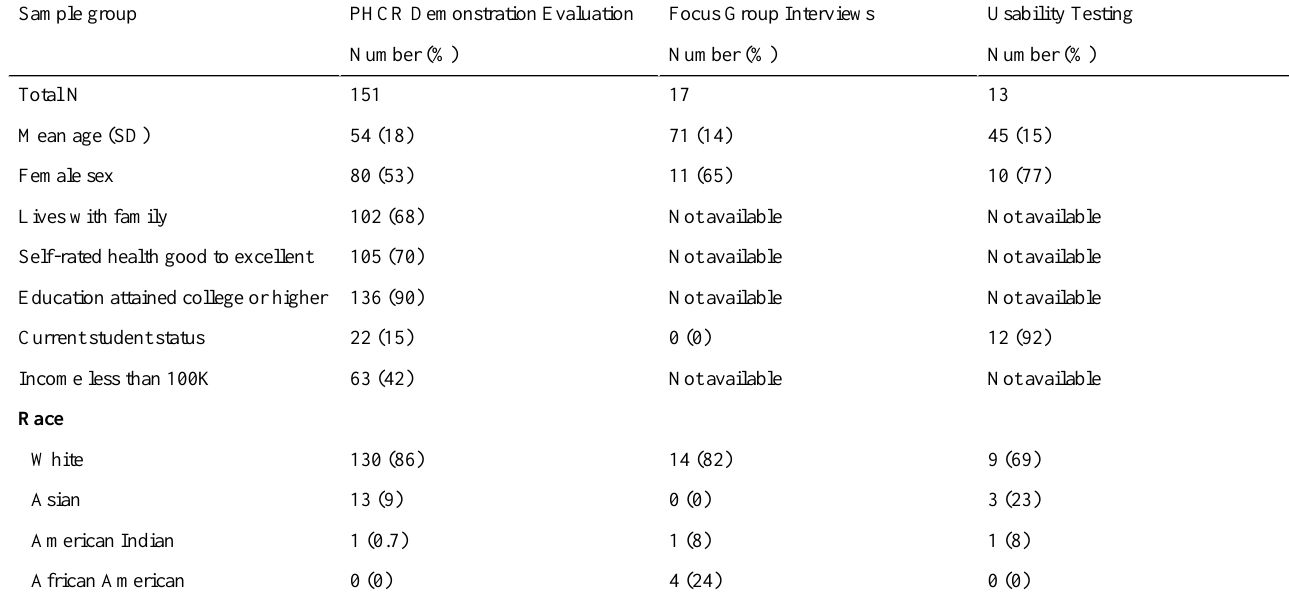
Table 1. Characteristics of study samples by